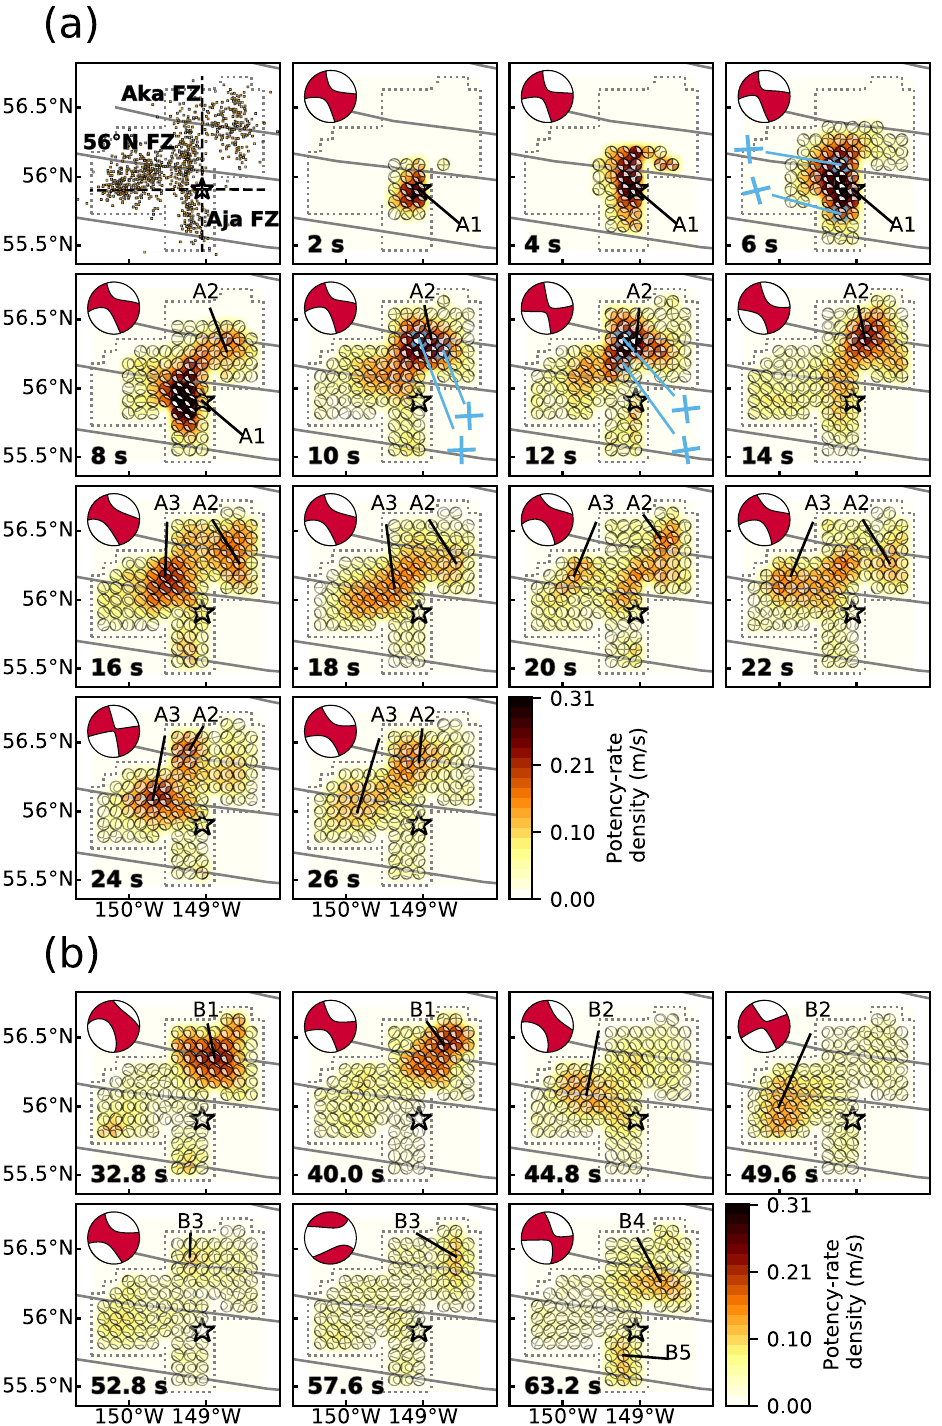
Figure 3. Snapshots of the potency-rate density tensors for ( a ) the main rupture stage A and ( b ) the secondary rupture stage B. The corresponding time after onset for each snapshot is noted at the bottom-left of each panel. The dotted line shows the border of the assumed model plane. The star and solid lines indicate the epicenter 1 and fracture zones 19,20 , respectively. Blue crosses show the strike directions of small beachball diagrams derived from the potency-rate density tensor. The top-left panel in ( a ) is the epicentral distribution of aftershocks ( M ≥ 3) that occurred within one week of the mainshock 1 . The large beachball in each panel indicates the corresponding total moment tensor at each time. The dashed lines on the left-top panel of ( a ) are the projection lines used for Fig. 4. This figure was made with matplotlib (v3.1.1) 48 and ObsPy (v1.1.0) 49